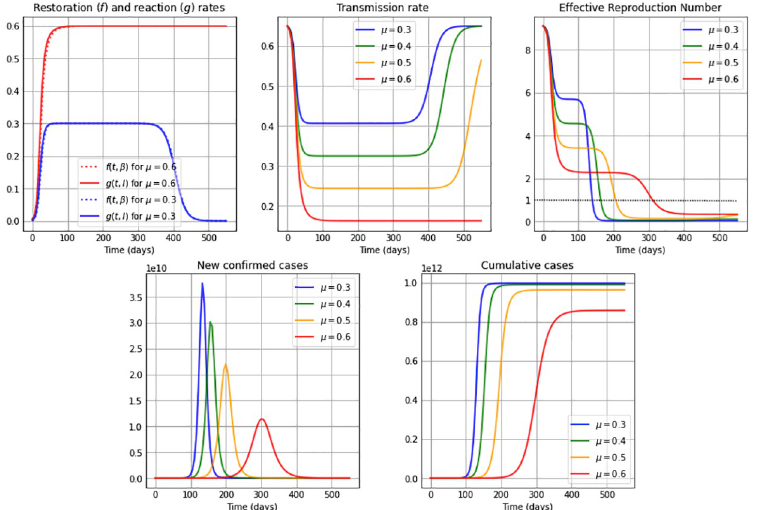
Fig 1. Simulations for a high restoration coefficient ν = 0.8. The first subplot illustrates the restoration rate f ( t , β ) (dotted) and the reaction rate g ( t , I ) (solid). The remaining subplots show: The transmission rate β ( t ), the effective reproduction number R ð t Þ , the new confirmed cases eE ( t ), and the cumulative cases E ( t ) + I ( t ) + R ( t ). The reaction e coefficient in each subplot are chosen to be μ : 0.3 (blue); 0.4 (green); 0.5 (orange) and 0.6 (red), and the remaining parameter values and initial conditions are as in Table